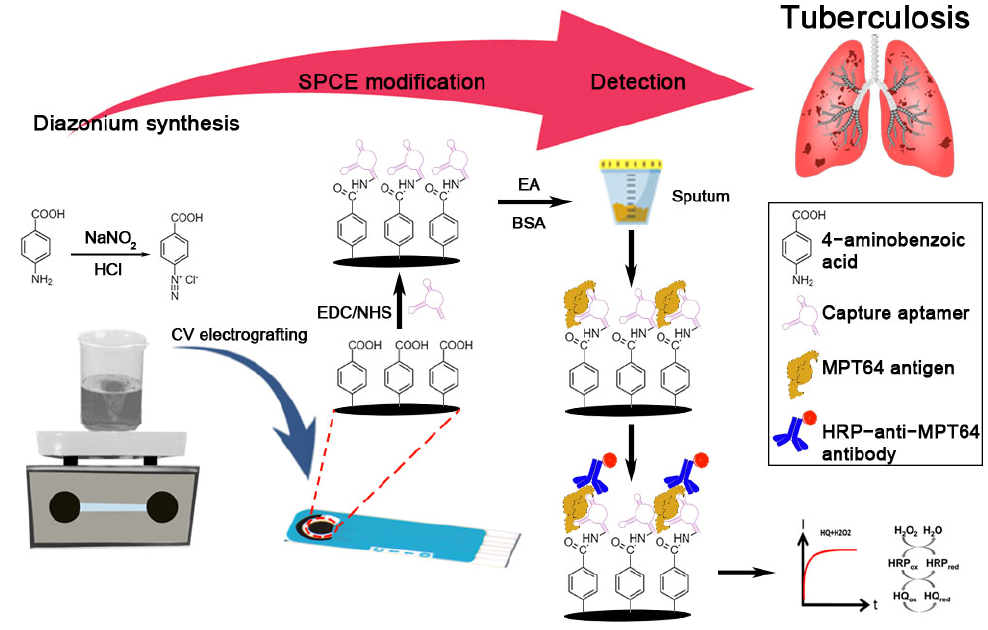
Figure 1. Schematic representation of fabrication of the aptasensor for the detection of MPT64 anti-